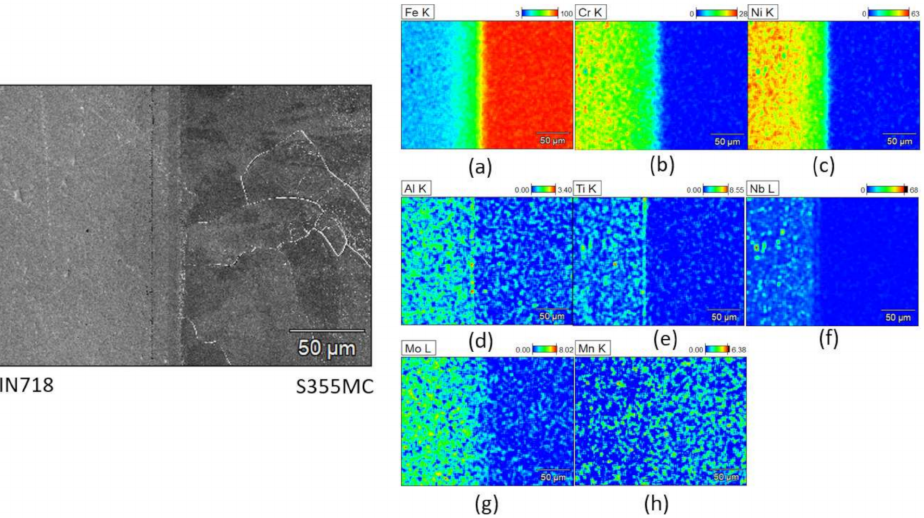
Figure 10. Micrographs of the structure and composition in weight % of the S355MC-IN718 joint area: ( a ) iron ( b ) chromium ( c ) nickel ( d ) aluminium ( e ) titanium ( f ) niobium ( g ) molybdenum ( h )